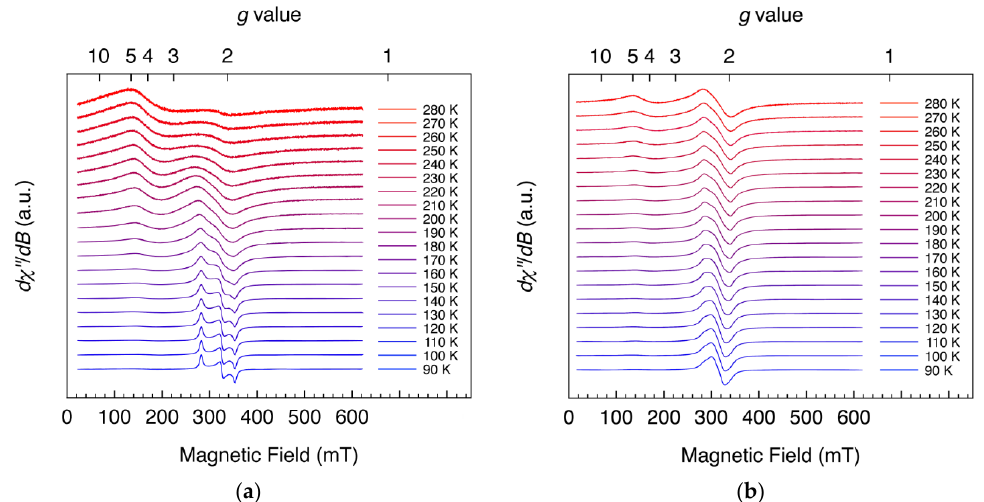
Figure 3. Continuous-wave (CW) X-band electron paramagnetic resonance (EPR) spectra of polycrystalline samples for ( a ) 1 and ( b ) 2 collected in the temperature 90–280 K in 10 K intervals.